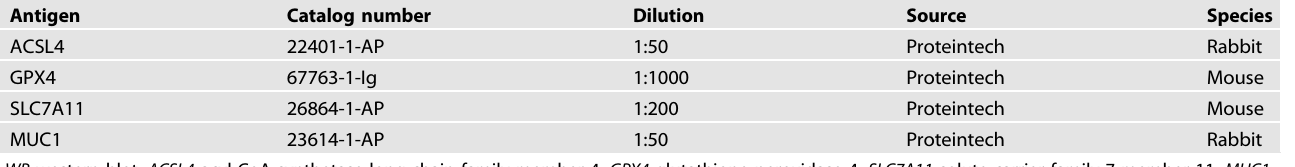
Table 3. Details of antigens used in immunohistochemistry analyses of EN and EC tissues.